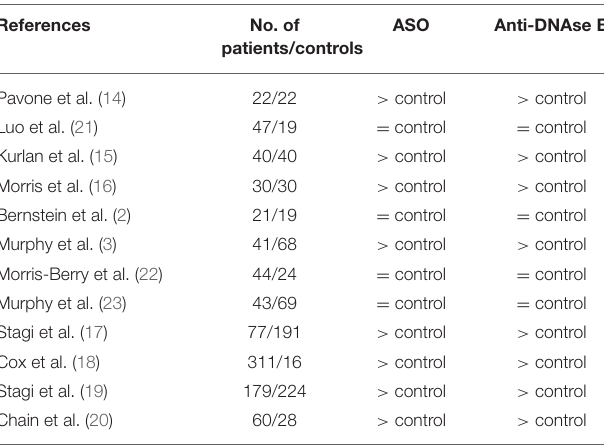
TABLE 2 | Studies that investigated titers of antistreptolysin-O (ASO) and anti-DNase B in patients with